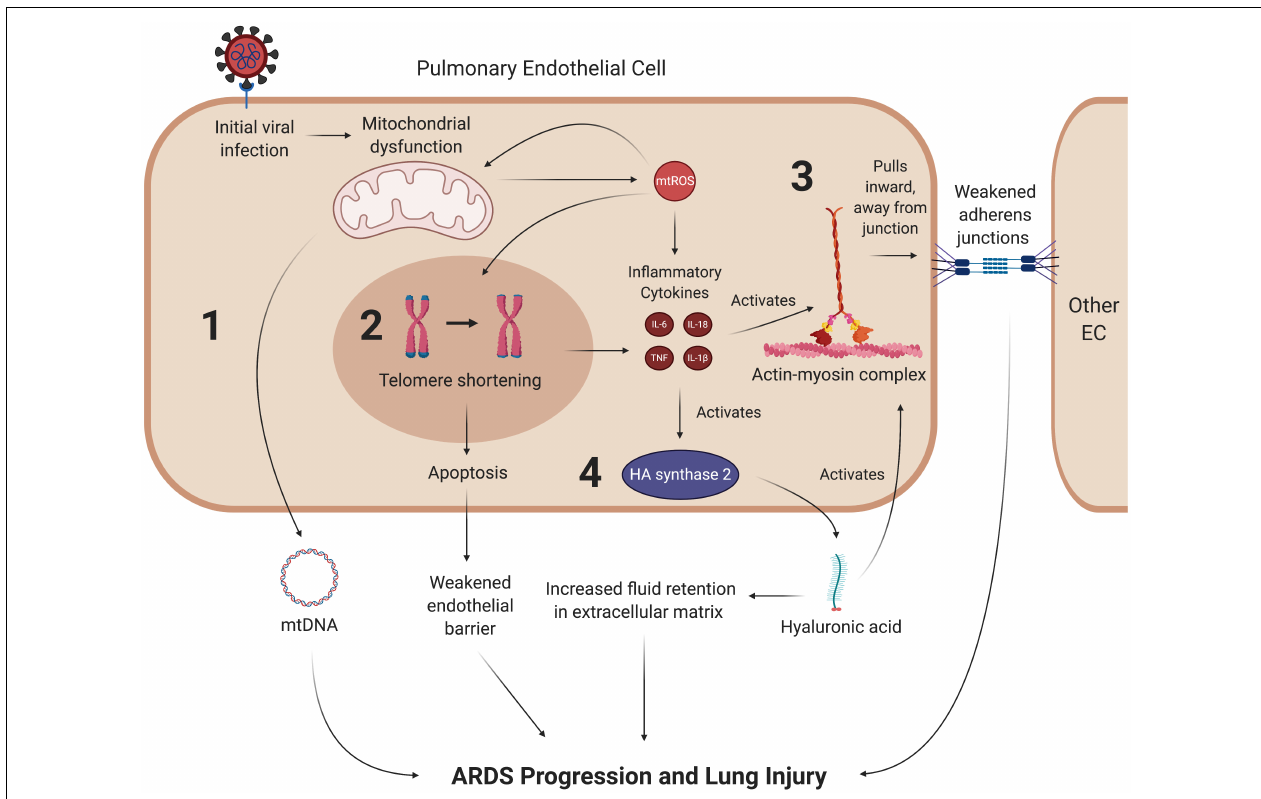
FIGURE 7 | SARS-CoV-2 may promote lung injury and ARDS through chronic mitochondrial dysfunction and inflammation. Once the coronavirus initially induces mitochondrial dysfunction in ECs, it may create a feedback loop that continually promotes vascular fluid leakage and lung injury, with four mechanisms depicted here. (1) Dysfunctional mitochondria are thought to eject mtDNA into the plasma, which is associated with fluid leakage and ARDS. While it is hypothesized that mtDNA in the plasma contribute to ARDS progression, the exact mechanism of this pathway remains to be clarified. (2) mtROS synthesized by dysfunctional mitochondria can induce senescence through various pathways, most notably by reacting to form hydroxyl ions that damage telomeres. Senescent cells undergo apoptosis at a much higher rate than their healthy counterparts, which further weakens the endothelial barrier. (3) Inflammatory cytokines weaken the endothelial barrier by activating the contractile actin-myosin complex, which pulls the VE-cadherin inward and away from its binding partner, thus opening a gap in the endothelial barrier. (4) These cytokines also lead to the activation of hyaluronic acid synthase 2, which synthesizes hyaluronic acid. Hyaluronic acid is thought to promote ARDS by activating the actin-myosin complex through RhoA kinase pathways and increasing fluid retention in the lung’s extracellular space. mtROS, mitochondrial reactive oxygen species; IL, interleukin; TNF, tissue necrosis factor; mtDNA, mitochondrial deoxyribonucleic